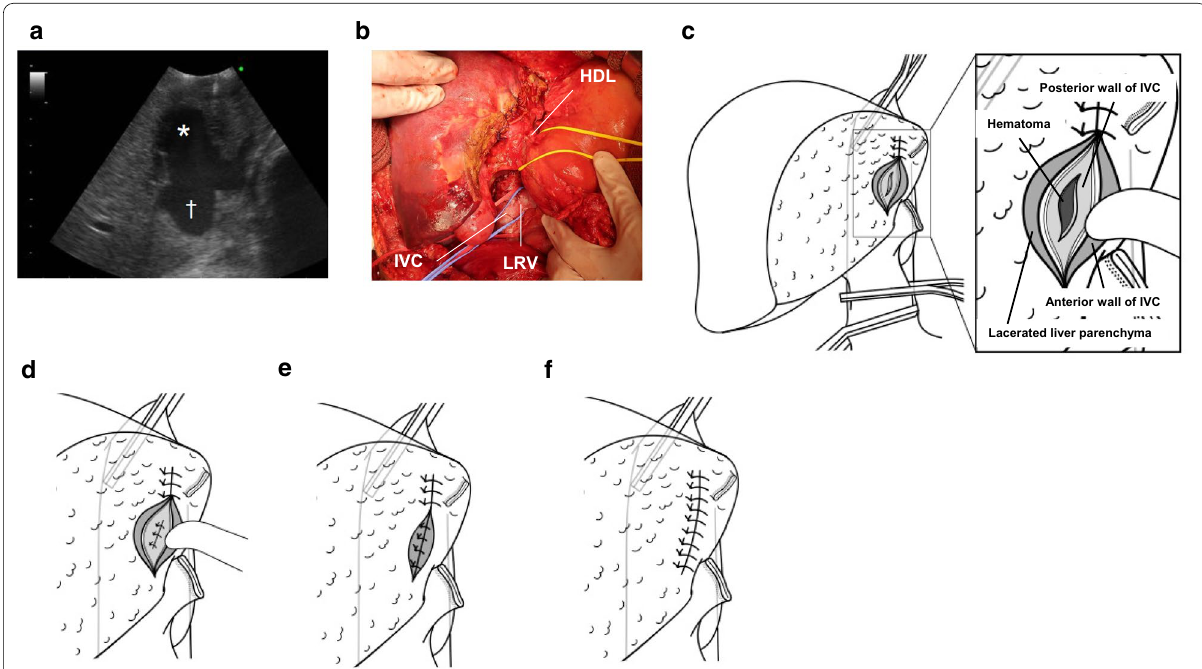
Fig. 2 Operative findings in the definitive surgery. a Intraoperative ultrasonography showing a free space (*) in front of the IVC (†), indicating IVC injury. b Taping of the HDL and major veins. HDL, hepatoduodenal ligament; LRV, left renal vein. c Observation of the lacerated IVC. The laceration penetrated the retrohepatic IVC through its posterior wall. Hematoma was observed behind the posterior wall of theretrohepatic IVC. d The posterior wall of IVC was sutured. e The anterior wall of IVC was sutured together with the lacerated hepatic parenchyma. f Liver parenchyma was sutured, and hemostasis was finally